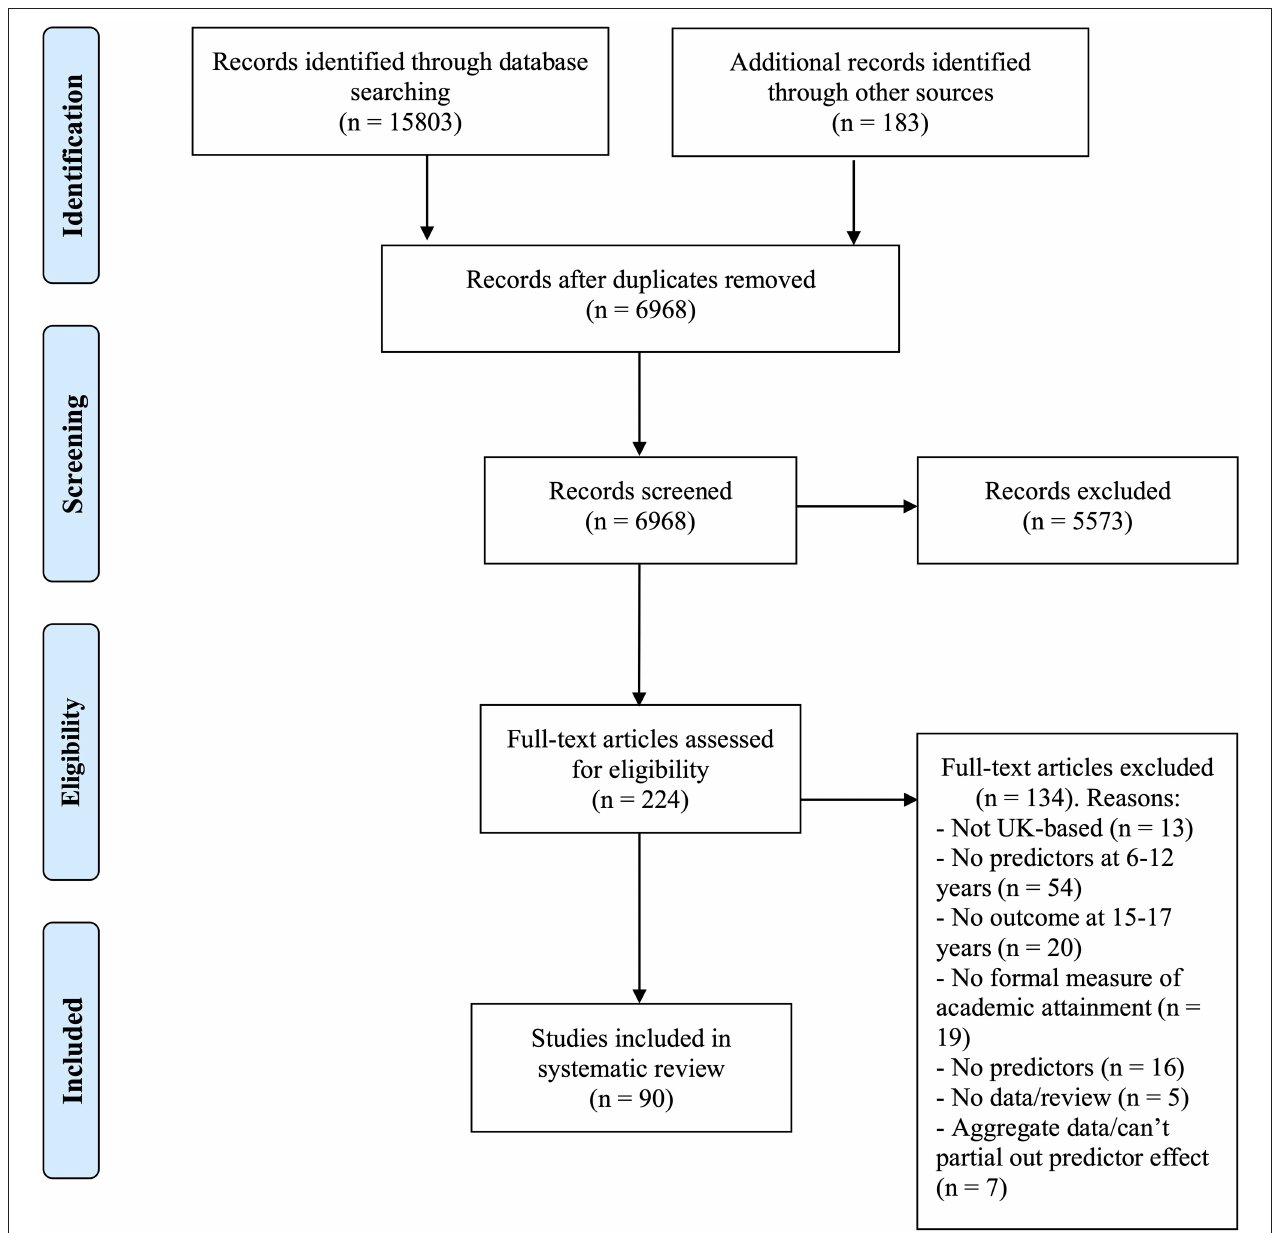
FIGURE 1 | PRISMA flow